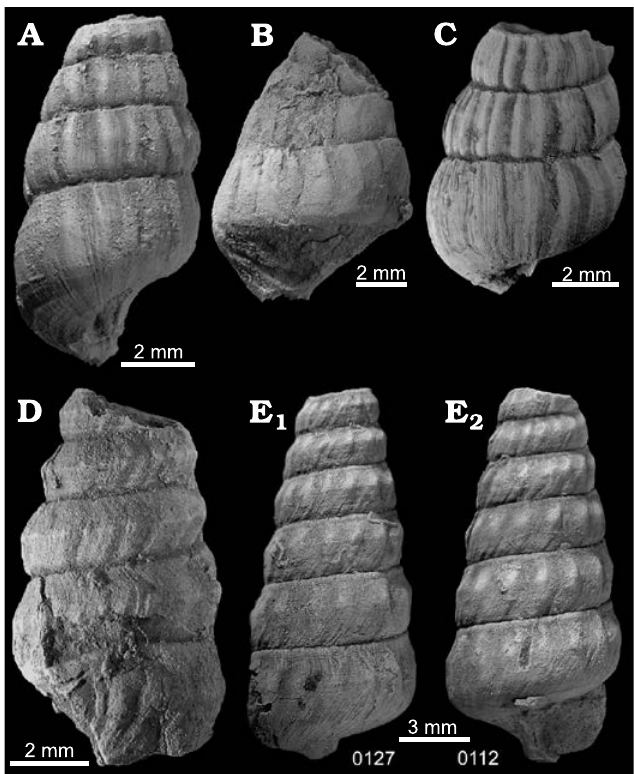
Fig. 19. Caenogastropods from Lago Antorno (A, B, D), Misurina Land slide (C) and Klipstein’s (1843) collection (E), northern Italy, Cassian For mation, Carnian, Upper Triassic. A . Kittliconcha aonis (Kittl, 1894), PZO 12834, in lateral view. B . Kittliconcha aonis (Kittl, 1894), PZO 12835, in lateral view. C . Kittliconcha aonis (Kittl, 1894); PZO 12710, in lateral view. D . Tyrsoecus zeuschneri (Klipstein, 1843); PZO 12837, in lateral view. E . Tyrsoe cus ze- uschneri (Klipstein, 1843), Klipstein’s (1843) illustrated type specimen (NHMUK PI OR 35421(1)), in lateral (E 1 ) and apertural (E 2 )